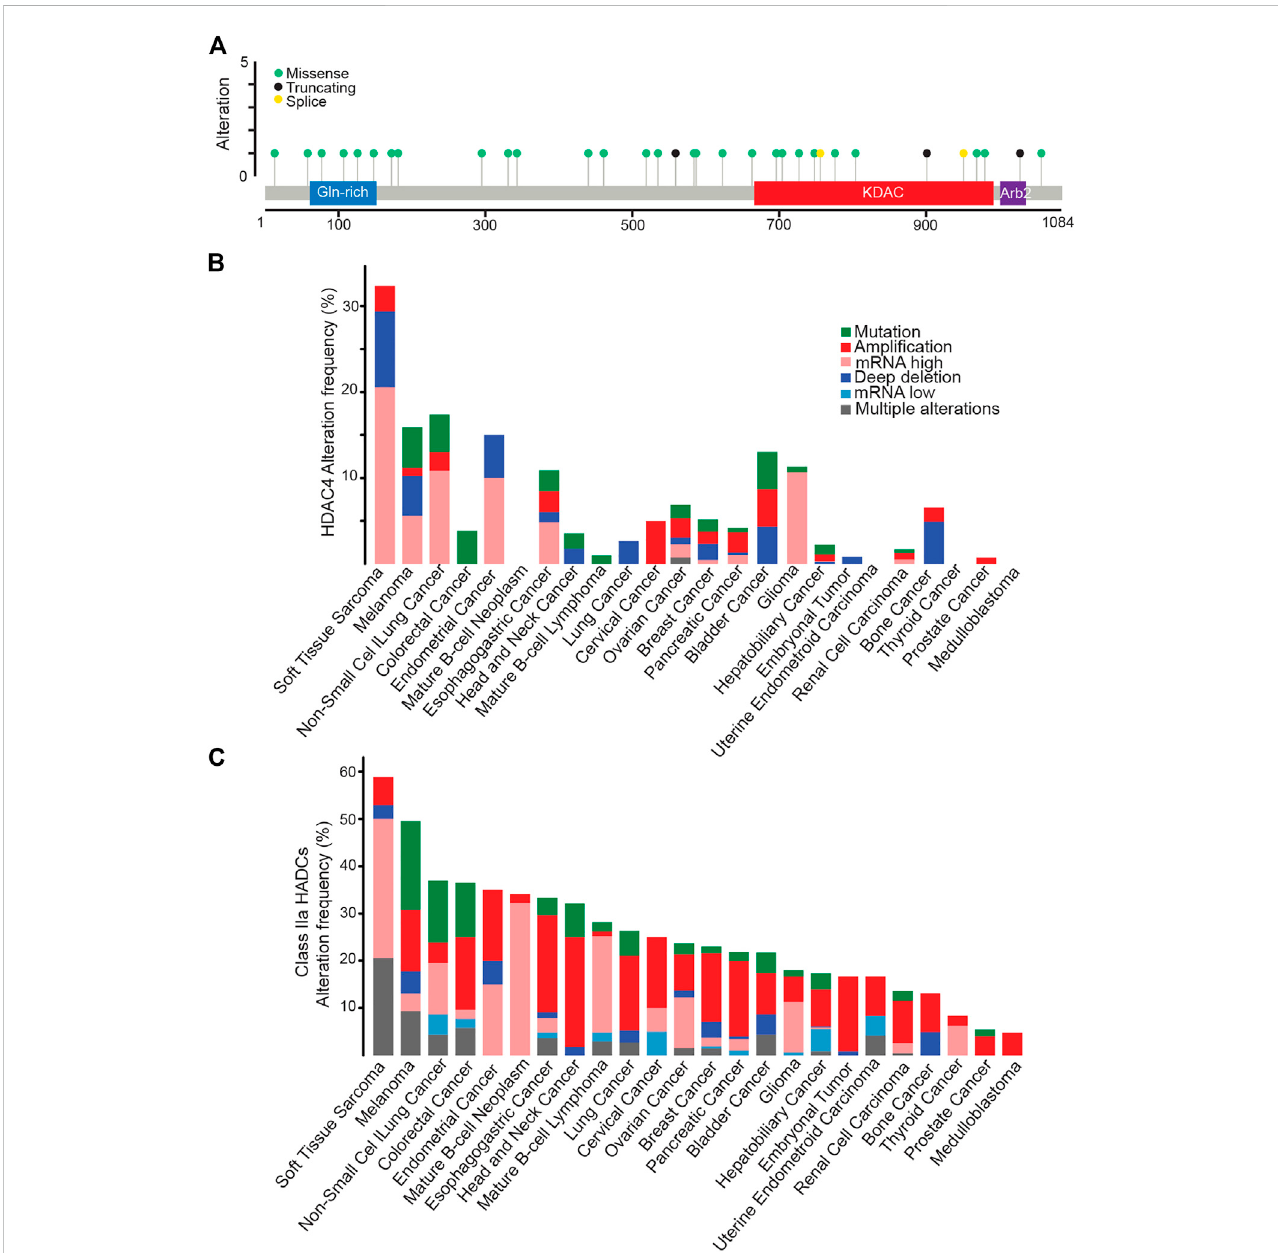
HDAC4alterationsincancer. (A) Mutationalpro fi leofHDAC4. (B) FrequencyofHDAC4alterationinsolidandliquidtumors. (C) ClassIIaHDACsalteration frequencyinsolidandliquidtumors.Datawereobtainedfromhttp://www.cbioportal.org.WGSchangescatalogedin2,583whole-cancergenomesandtheir matched normal tissues across 38 tumor types. Source data from UCSC Xena and ICGC Data